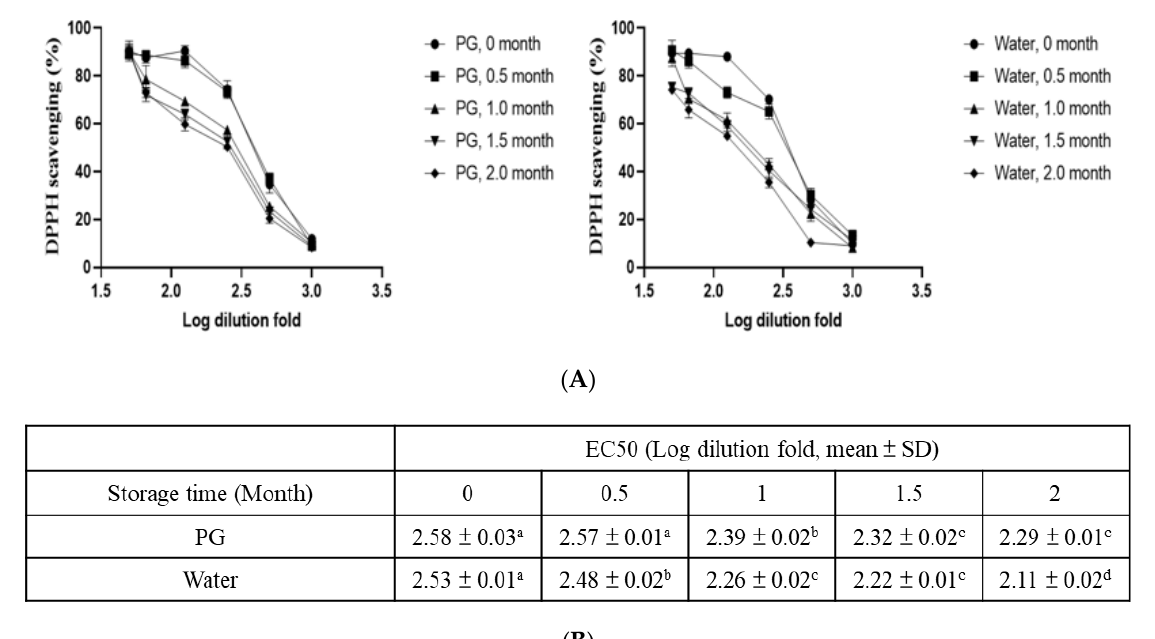
Figure 4. The antiradical activity ( A ) and EC50 ( B ) of the Scutellaria baicalensis extract (SBE) stored in 20% PG and water for different numbers of months. The data are presented as the mean ± SD (n = 3). Letters indicate significant differences within each group at p < 0.05.